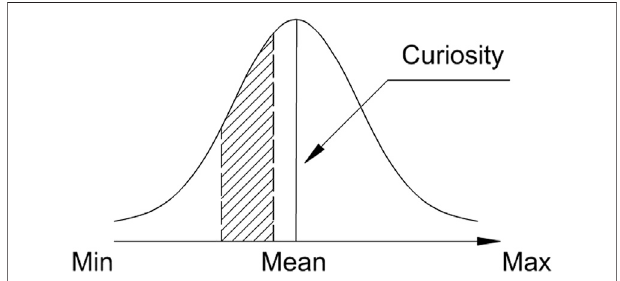
Frontiers in Robotics and AI |